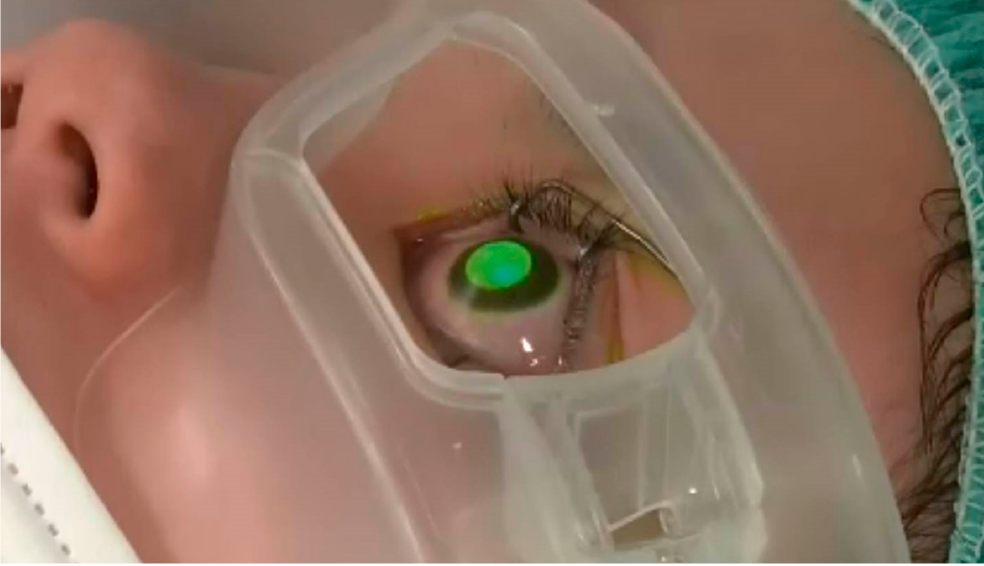
Figure 1. Application of the oxygen delivery goggles (Boost Goggles, Avedro Inc., Waltham, MA, USA). The difference map shows flattening of 3.0 D in the steep areas and steepening of 1.6 D in the